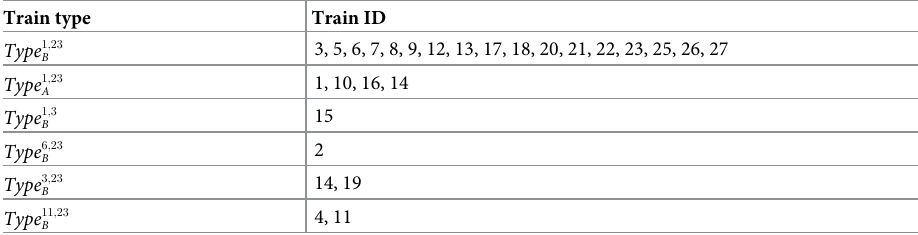
low and can be met without many stops. Conversely, the frequency of service at some small- sized stations has increased because the low but not concentrated passenger flow needs more services to be satisfied. Therefore, the optimized stopping plan is more in line with the real situation. The second phase Based on the generated stop plan, train operation parameters and expected departure times, a new timetable is obtained from the proposed timetabling model by minimizing the train travel Table 6. Train types according to train operating speed and terminal